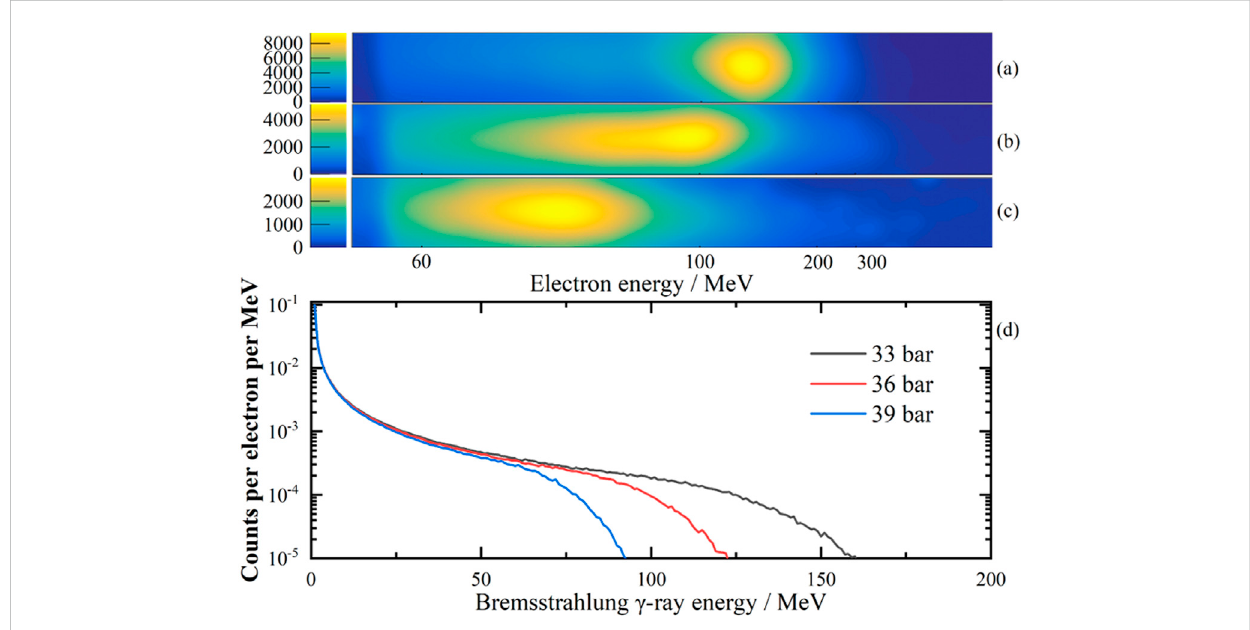
FIGURE 1 (A – C) are the typical LWFA electron spectra obtained by the magnetic spectrometer at gas pressure of 33, 36, 39 bar, respectively. (D) is the bremsstrahlung γ -ray energy spectra obtained from GEANT4 simulations using the averaged electron spectra of 100 continuous